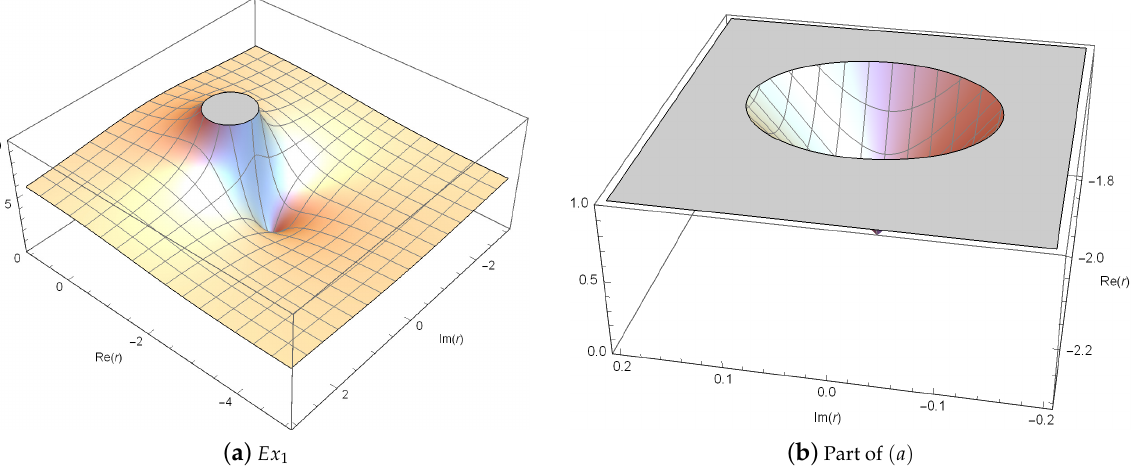
Figure 1. Stability surfaces of Ex 1 =